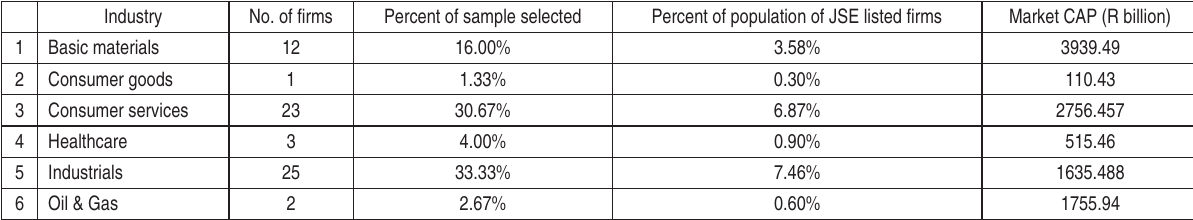
Table 2. Listed non-financial firms with complete data (1 Jan 2003 to 31 Dec